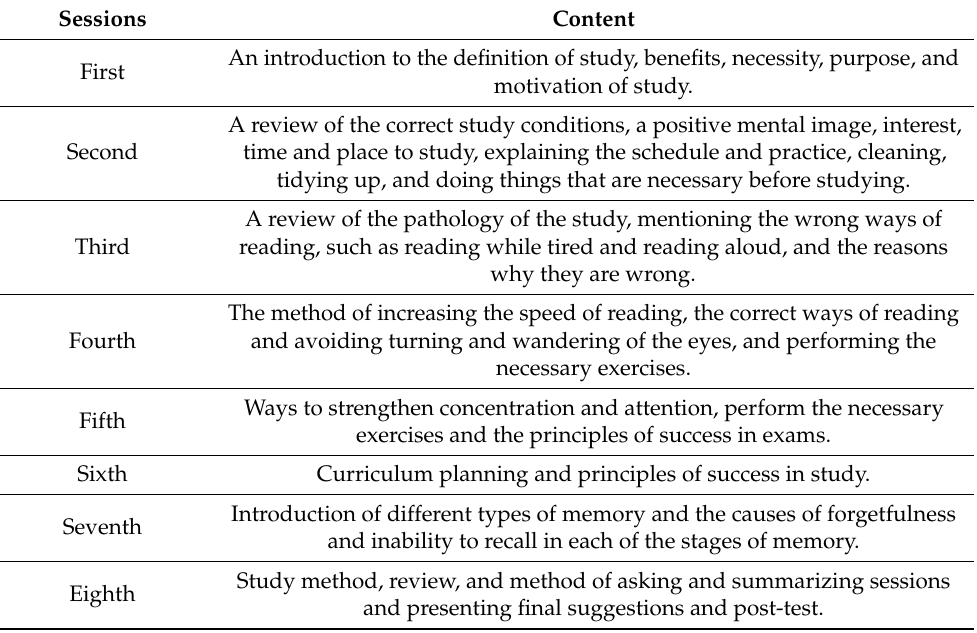
Table 1. Steps of training sessions of study